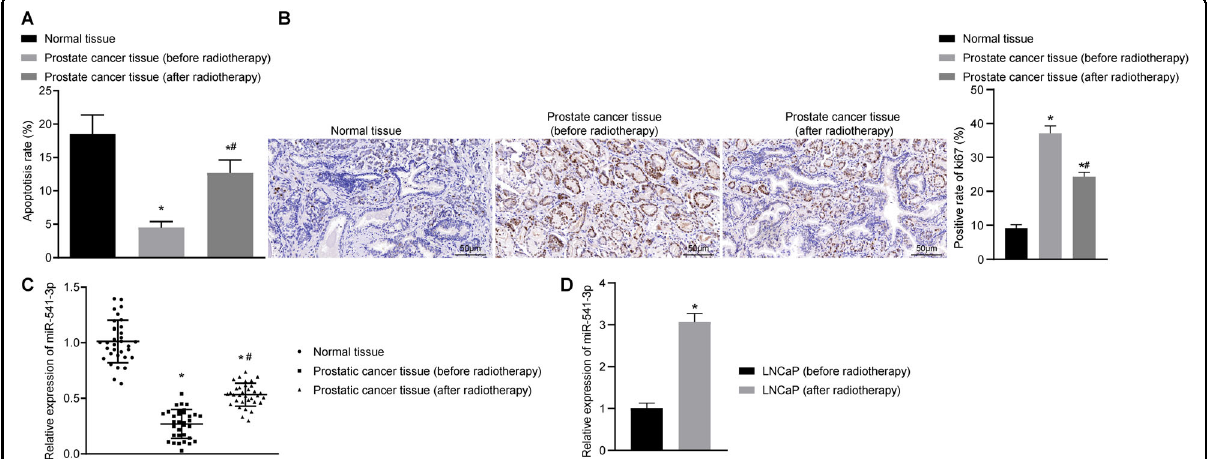
Fig. 1 The expression of miR-541-3p is downregulated in PCa tissues but elevated after radiotherapy. A TACS TdT in situ apoptotic index (AI) of adjacent normal tissues and PCa tissues before and after radiotherapy. B The Ki67 expression in adjacent normal tissues and PCa tissues before and after radiotherapy detected by immunohistochemistry. C The expression of miR-541-3p in adjacent normal tissues and PCa tissues before and after radiotherapy determined by RT-qPCR. D The expression of miR-541-3p in LNCaP cells before or after radiation determined by RT-qPCR. Values were expressed as mean ± SEM, * p < 0.05 relative to adjacent normal tissues and # p < 0.05 relative to PCa tissue before radiotherapy. Paired t -test was used for comparison between the two groups, n =